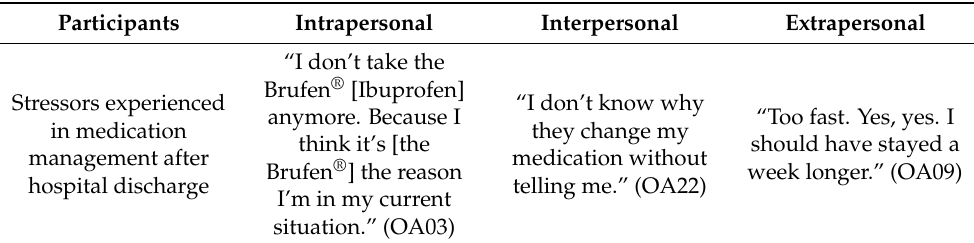
Table 2. An example of coding the data to the categorisation matrix through deductive content analysis within the